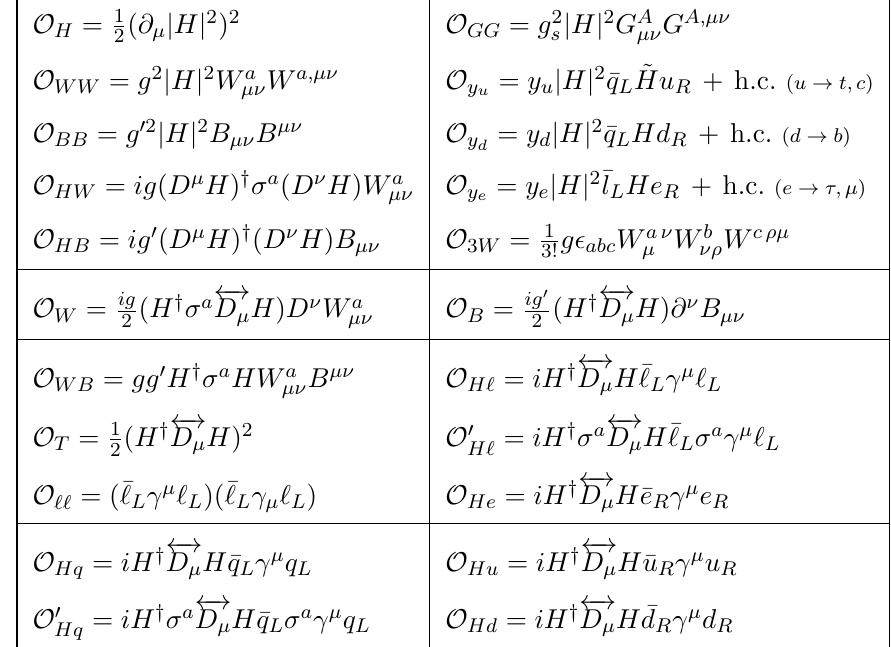
Table 3 . A redundant set of dimension-six operators that contributes to the Higgs and EW processes in our analysis. Flavour indices are omitted. The operators O WW , O WB , and the (cid:13)avour universal components of O H‘ and O 0 are eliminated in the SILH’ basis; O W , O B , O H‘ and O 0 H‘ are eliminated in the modi(cid:12)ed-SILH’ basis; O W , O B , O HW and O HB are eliminated in the Warsaw